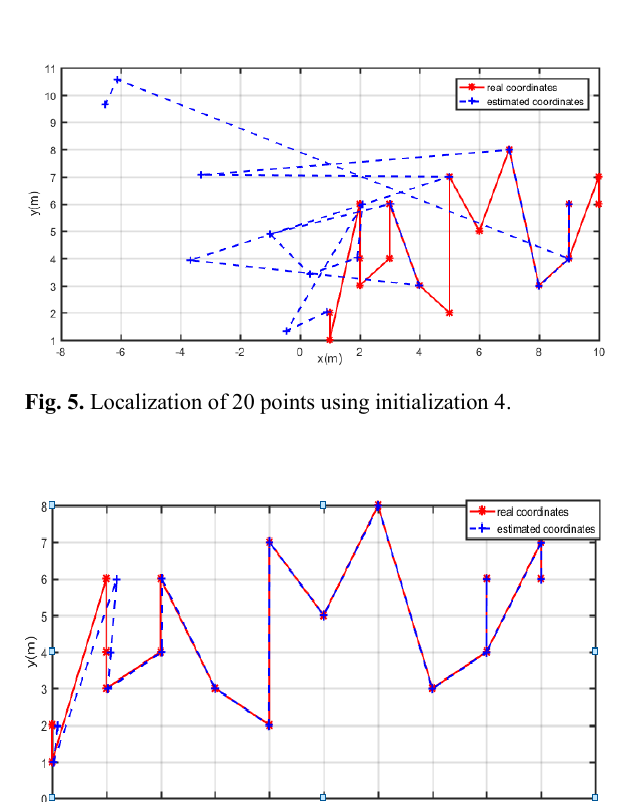
Fig. 6. Localization of 20 points using initialization 3.